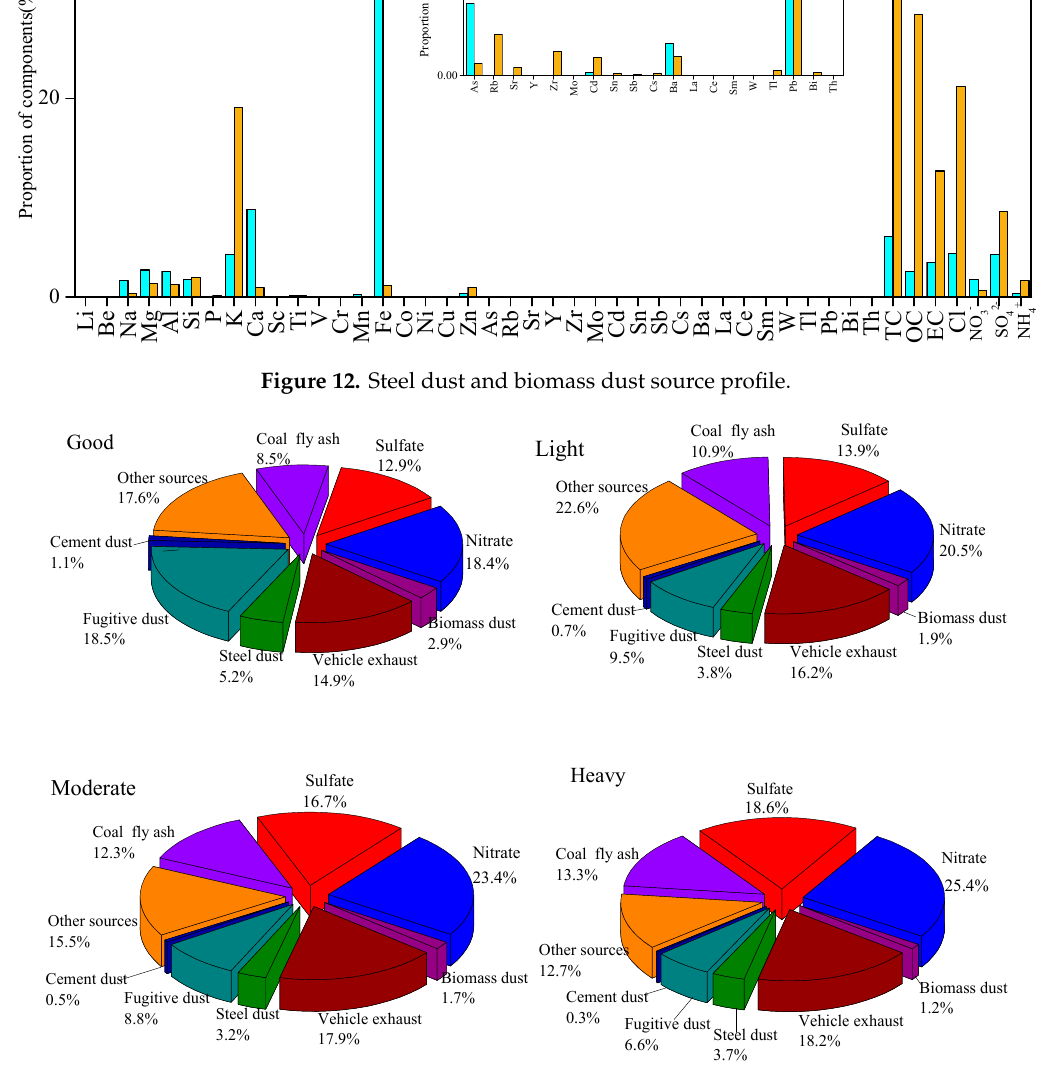
Figure 13. Source contribution to ambient PM 2.5 in four pollution days in Jinan.